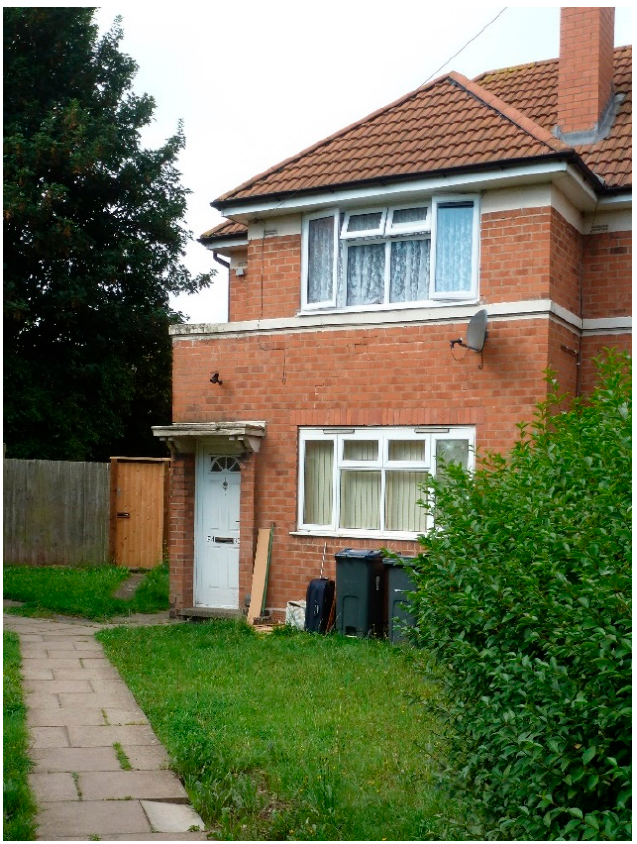
Figure 4. Sheila’s home in Matlock Road (ground floor flat), Tyseley Birmingham 1949–1956 (photo- graph taken